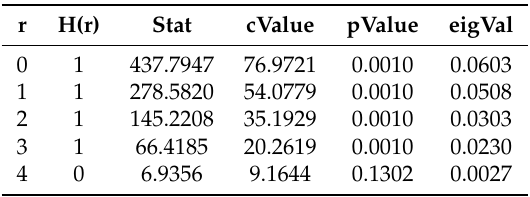
Table 2. Johansen trace test with a significance level of